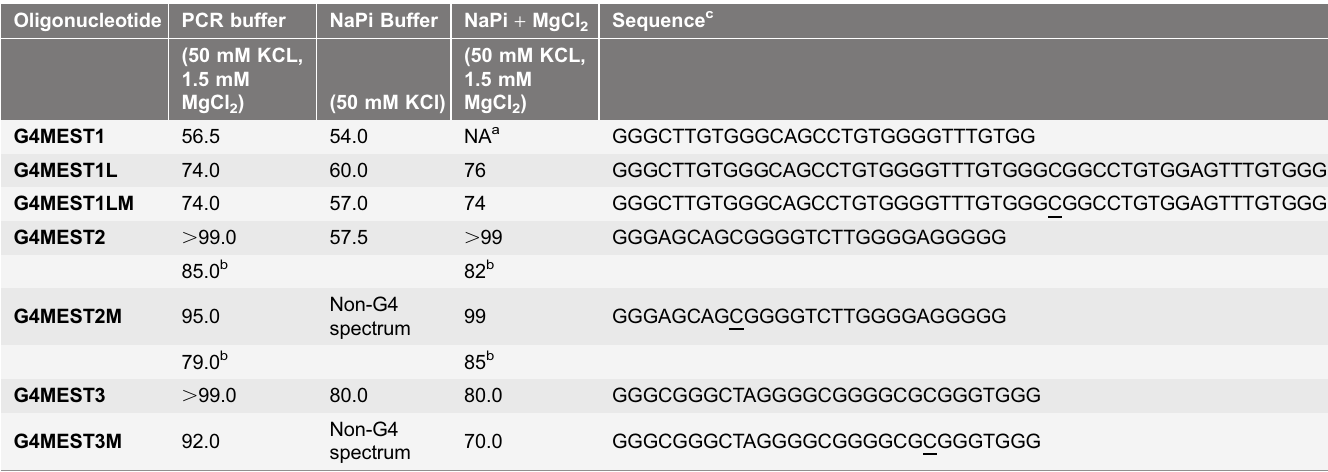
Table 1. G4 melting temperatures in different buffers, T m ( ˚ C).